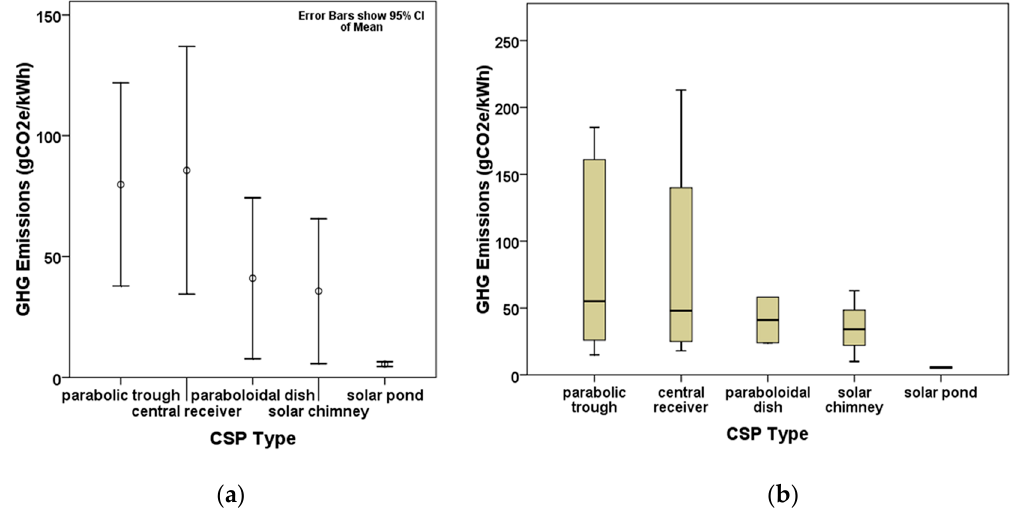
Figure 4. GHG emissions from CSP electricity generation systems: ( a ) mean ± 95% CI error bars and ( b ) quartile box plots. Table 6. GHG emission (gCO 2 e/kWh) statistics from CSP electricity generation